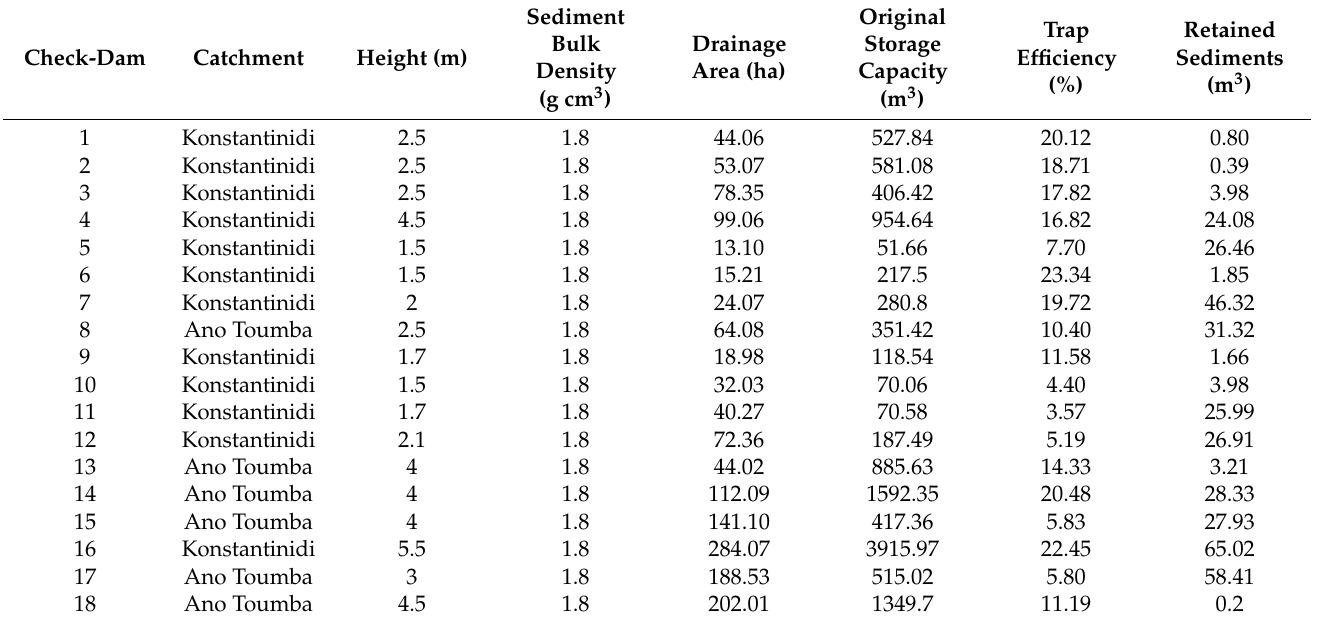
Table 4. Check-dam main characteristics and trap